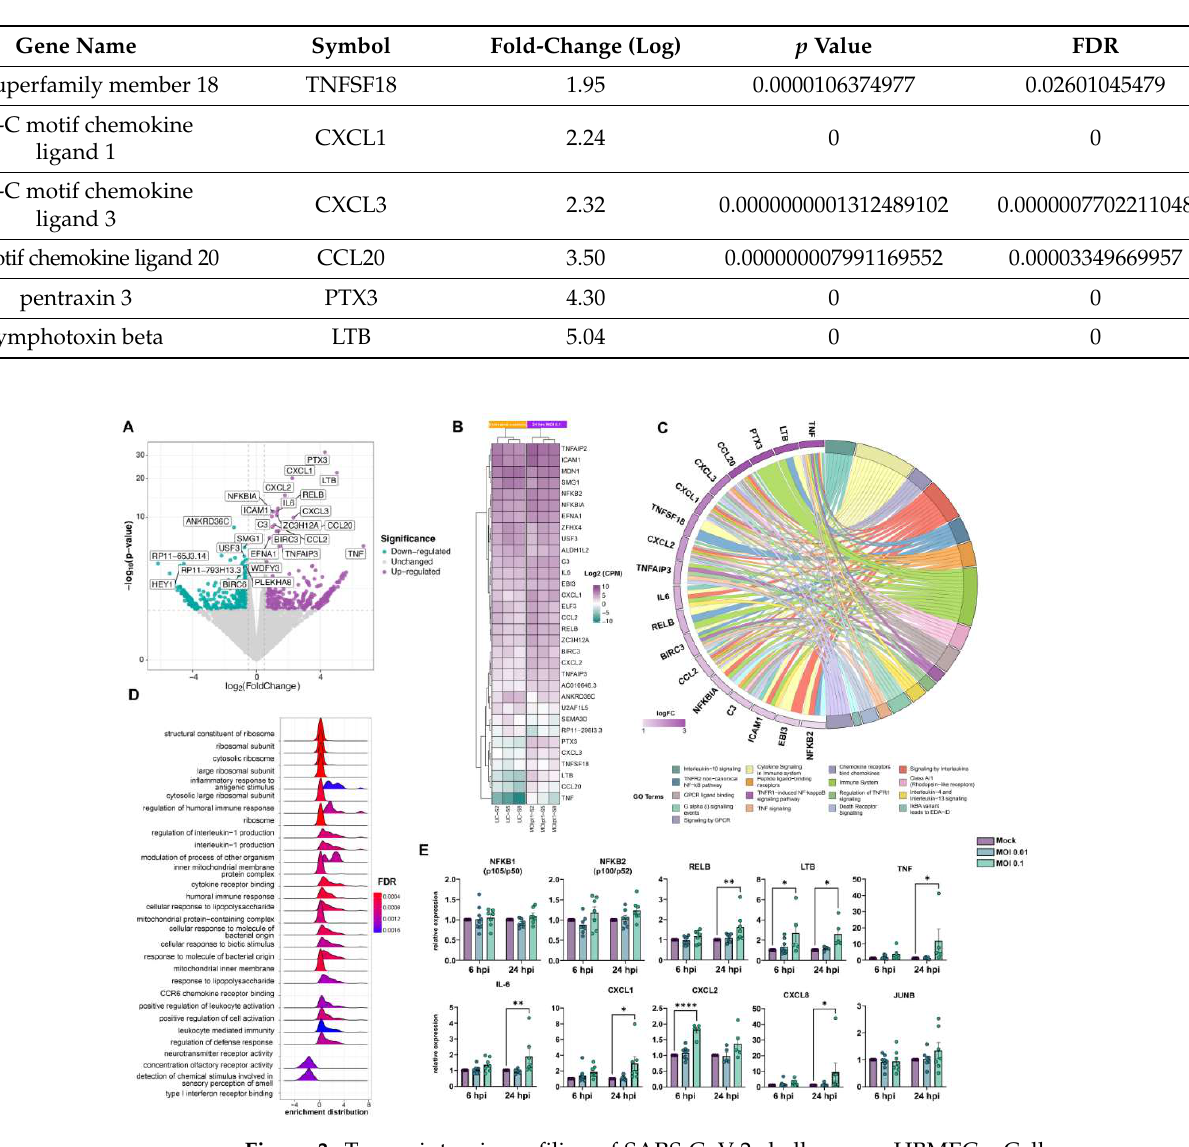
Figure 3. Transcriptomic profiling of SARS-CoV-2 challenge on HBMECs. Cells were exposed to MOIs 0.01 and 0.1 and analyzed by RNA-Seq. ( A ) Volcano plot depicting the overall profile of differentially expressed genes in cultures after 24 h exposure to the MOI 0.1, with up-regulated genes shown in purple and down-regulated—in green. ( B ) Heatmap diagram depicting expression levels of the most significantly altered genes by MOI 0.1 (3 right columns), as compared to uninfected controls (3 left columns). ( C ) Cnetplot visualization of functional enrichment results with up-regulated genes, depicting the functional correlation of genes with the most significant GO terms. ( D ) Enrichment functional analysis of GO terms most affected by SARS-CoV-2 challenge in HBMECs indicates inflammatory endothelial activation, as well as mitochondrial dysfunction and ribosomal-related gene expression. ( E ) RT-qPCR validation of most significantly altered genes detected in the RNA-Seq indicates activation of non-canonical NF- κ B pathway, with massive increase in TNF- α , lymphotoxin B (LTB, or TNF-C), and downstream target genes, such as IL-6, CXCL1, -2, and -8. NFKB1 (p105/p50) and NFKB2 (p100/p52), as well as JUNB, showed no significant alteration in